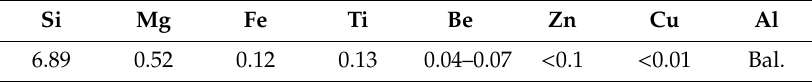
Table 1. Chemical composition of the ZL114A aluminum alloy (wt.%).